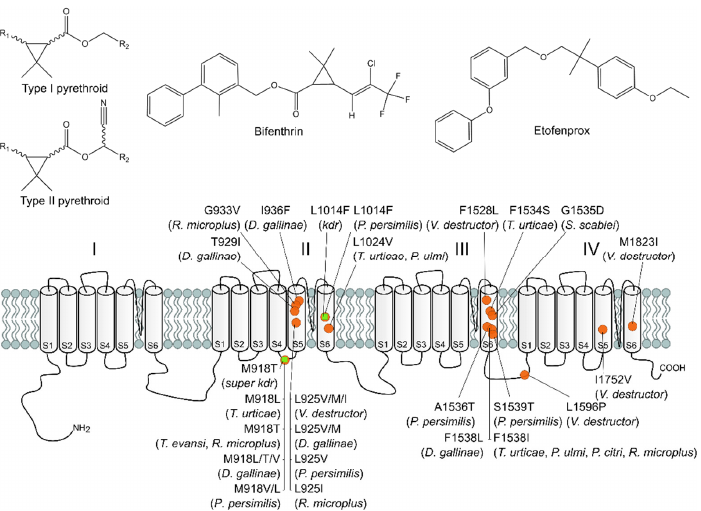
Figure 1. Pyrethroids and their target-site, the voltage gated sodium channel (VGSC; drafted from Van Leeuwen et al. [14]). ( a ) Chemical structure of Type I and II pyrethroids, the ester-pyrethroid bifenthrin and the non-ester pyrethroid etofenprox. ( b ) Schematic presentation of the VGSC, composed of four repeat domains (I–IV), each containing six membrane spanning helices (S1–S6). The positions of resistance mutations—found in T. urticae and other Acari species—involved in pyrethroid resistance are depicted with orange circles, while the kdr and super kdr mutations, identified in many insects, are depicted with green squares (numbering according to Musca domestica ) [14-32] . Pyrethroids are mainly used in agriculture for controlling insect and mite pests [6,33] but are also frequently applied in vector-borne disease control and veterinary medicine [34-36]. Due to their widespread application and long-term usage, many cases of pyrethroid resistance have been reported, including for the two-spotted spider mite Tetranychus urticae (Chelicerata: Acari) [37,38]. This species is highly polyphagous and an important pest on agricultural crops worldwide [3,39]. Due to its high fecundity, arrhenotokous reproduction and short life cycle, it rapidly develops resistance against acaricides [3,40]. Resistance mechanisms can be classified into toxicokinetic mechanisms—including decreased exposure to the toxic substance due to increased metabolism, decreased penetration, sequestration or increased excretion—and toxicodynamic mechanisms such as decreased sensitivity of the target-site towards the insecticide [31]. In the case of pyrethroid resistance, toxicodynamic resistance has been shown to be the most important mechanism [1], and “knockdown resistance” or kdr was first described in houseflies ( Musca domestica ) by Busvine [41]. The kdr trait causes a loss of sensitivity to DDT and pyrethroids due to a reduction in the binding of pyrethroids to the VGSC. In several cases, the kdr trait is accompanied by a second resistance trait named super-kdr , which confers an even higher resistance to pyrethroids [42]. In follow-up studies, the reduced insecticide binding was attributed to the presence of mutations in the VGSC, with the kdr mutation (L1014F) being documented globally in many major arthropod pests and disease vectors (reviewed in Rinkevich, Du and Dong [10]). For the Tetranychus species, several mutations in the VGSC have also been associated with decreased sensitivity towards Type I and Type II pyrethroids: point mutations M918L/T or L925M in the intracellular linker connecting transmembrane segments IIS4 and IIS5 (where M918L was found in combination with F1534S in IIIS6), L1024V at the terminus of